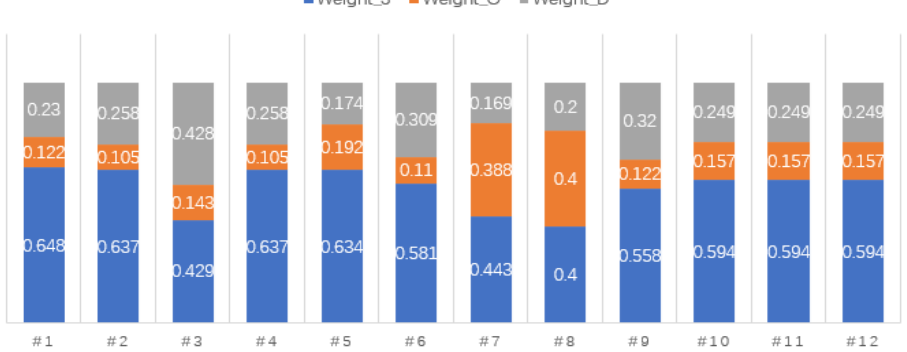
Figure 6. S, O, D weight of each failure mode.